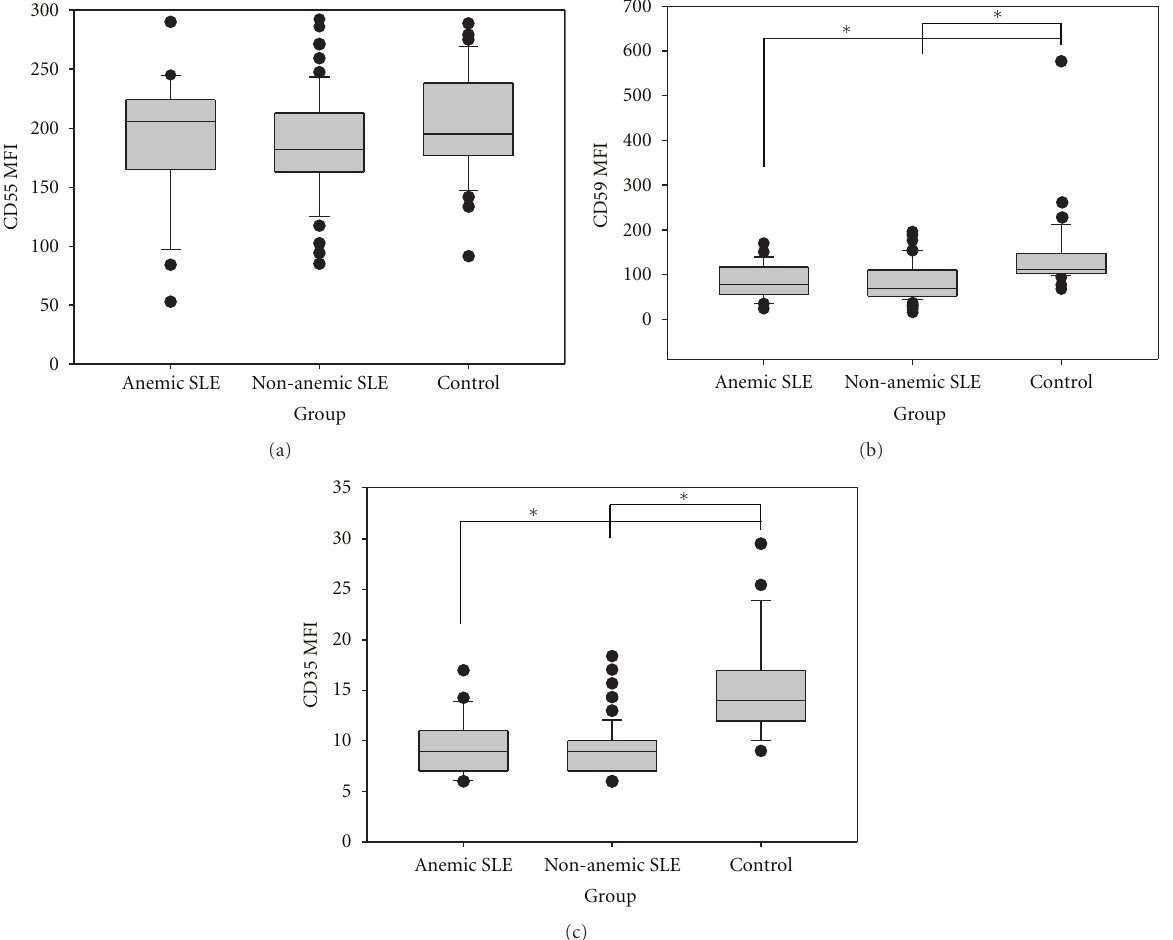
Figure 3: Creg surface expression of RBC. The figure displays mean fluorescence intensity (MFI) of CD55, CD59, CD46, and CD35 on gated RBC from SLE patients with anemia, without anemia, and controls. Median and interquartile range from all subjects studied in each group were shown. ∗ Significant statistical di ff erence ( P < 0 .